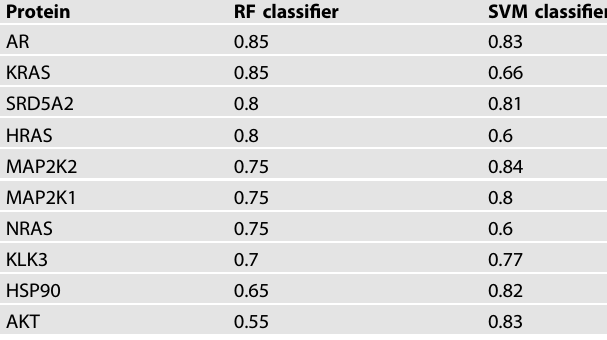
Table 2. Top ten PCBP1-AS1-binding proteins*.